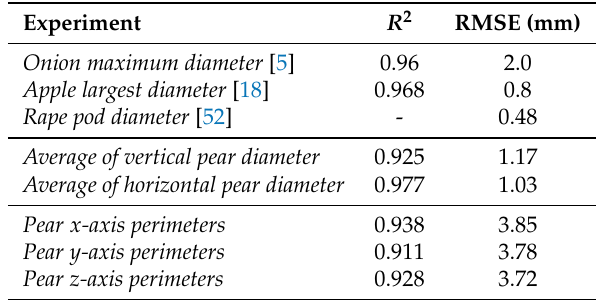
Table 1. Comparison of the method in this paper with other